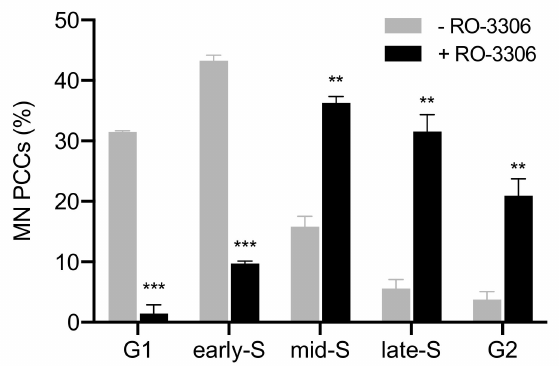
Figure 4. Cell cycle distribution of MN PCCs generated by irradiated G 0 -lymphocytes. Frequencies of five di ff erent cell cycle phase categories of MN PCCs scored in heterophasic micronucleated cells, generated by irradiation of G 0 -lymphocytes, upon entry of main nuclei into mitosis. Based on the progress of completion of DNA replication, the chromosomes in the interphase MN can be classified as being in G1, early-S, mid-S, late-S, or G2 phase. The agent RO-3306, a selective ATP-competitive inhibitor of CDK1, was used for 20 h to delay the entrance of main nuclei into mitosis, thus allowing time for completion of DNA replication in MN. In the absence of RO-3306, 75% of MN PCCs are in G1 and early-S phase, while only 25% are in mid-S, late-S, and G2 phase. In the presence of RO-3306, only 11% of MN PCCs are in G1 and early-S phase, while 36% are in mid-S, 32% in late-S, and 21% in G2. As the DNA replication progresses and MN proceed towards G2 phase, the observed chromosome shattering decreases. (Mean ± SEM based on two independent experiments; a total of 457 MN PCC spreads were analyzed; ** p ≤ 0.01, *** p ≤ 0.001).